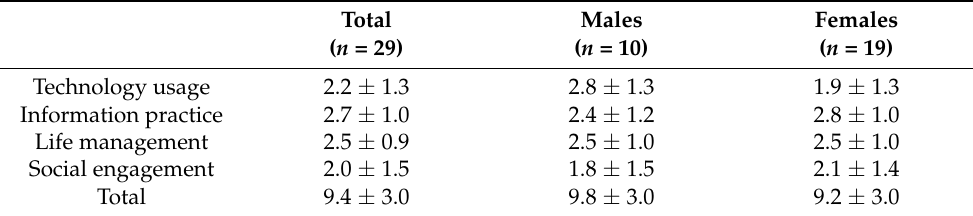
Table 2. JST-IC scores as representative of IADL.